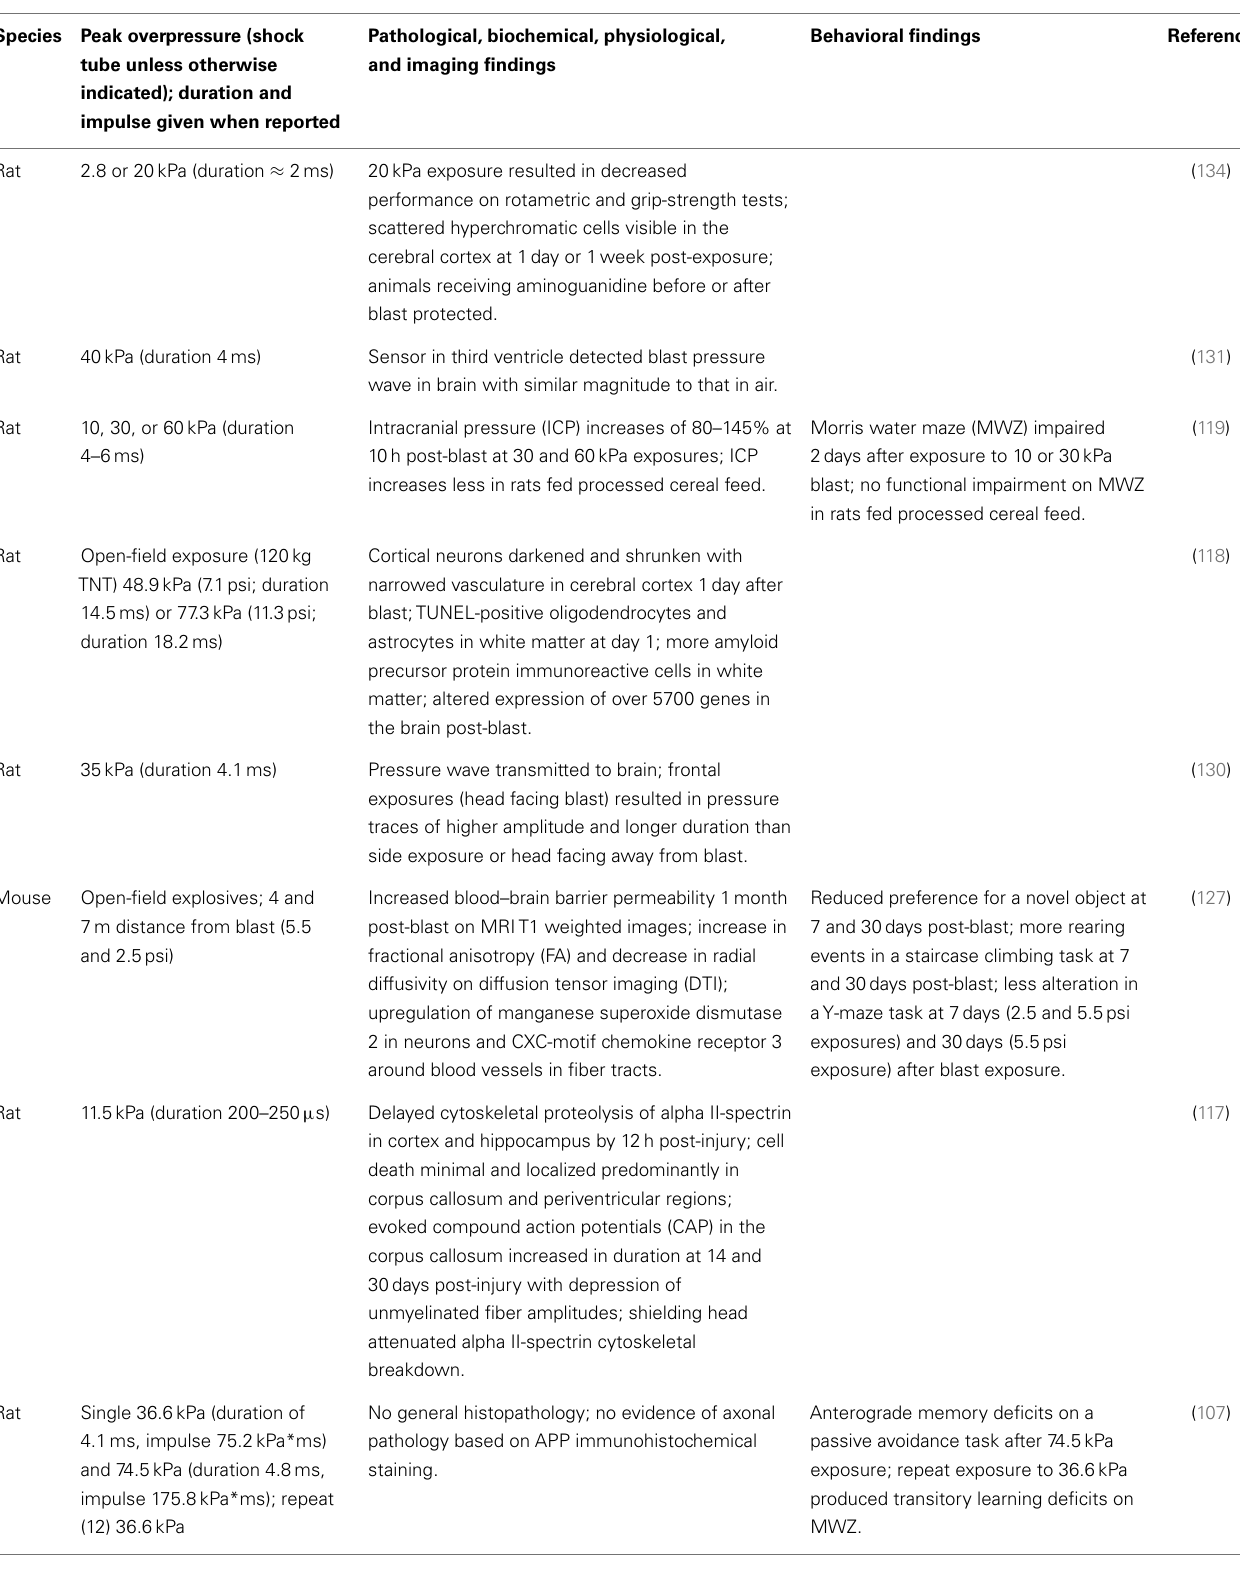
Table 2 | Effects of low-level blast exposure in animal models . Species Peak overpressure